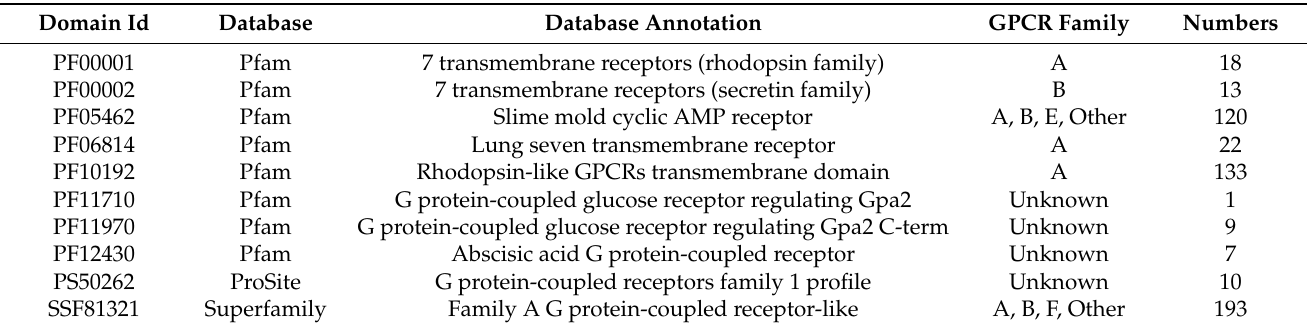
Table 1. Distribution of GPCRs in different protein domain categories.